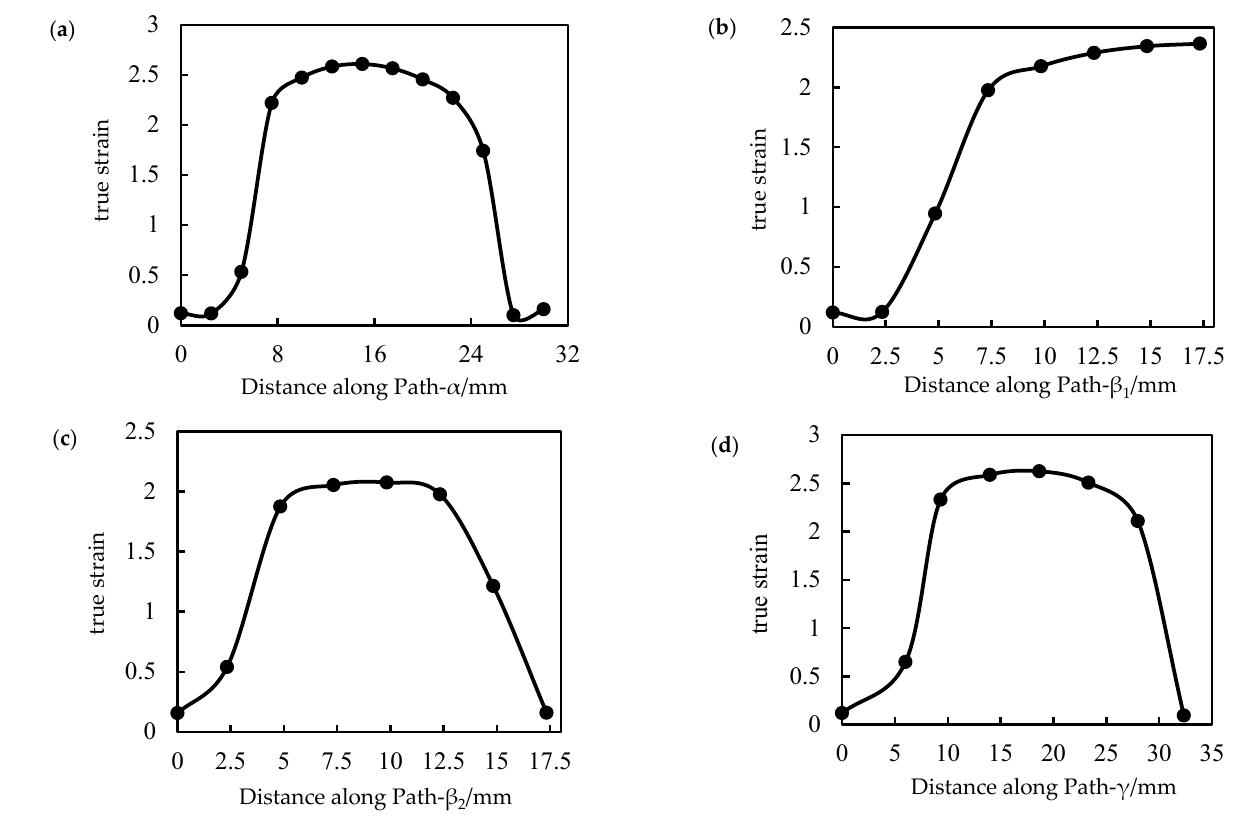
along Path- β 1, ( c ) 90° sub-bar along Path- β 2, ( d ) oblique rib along Path- γ